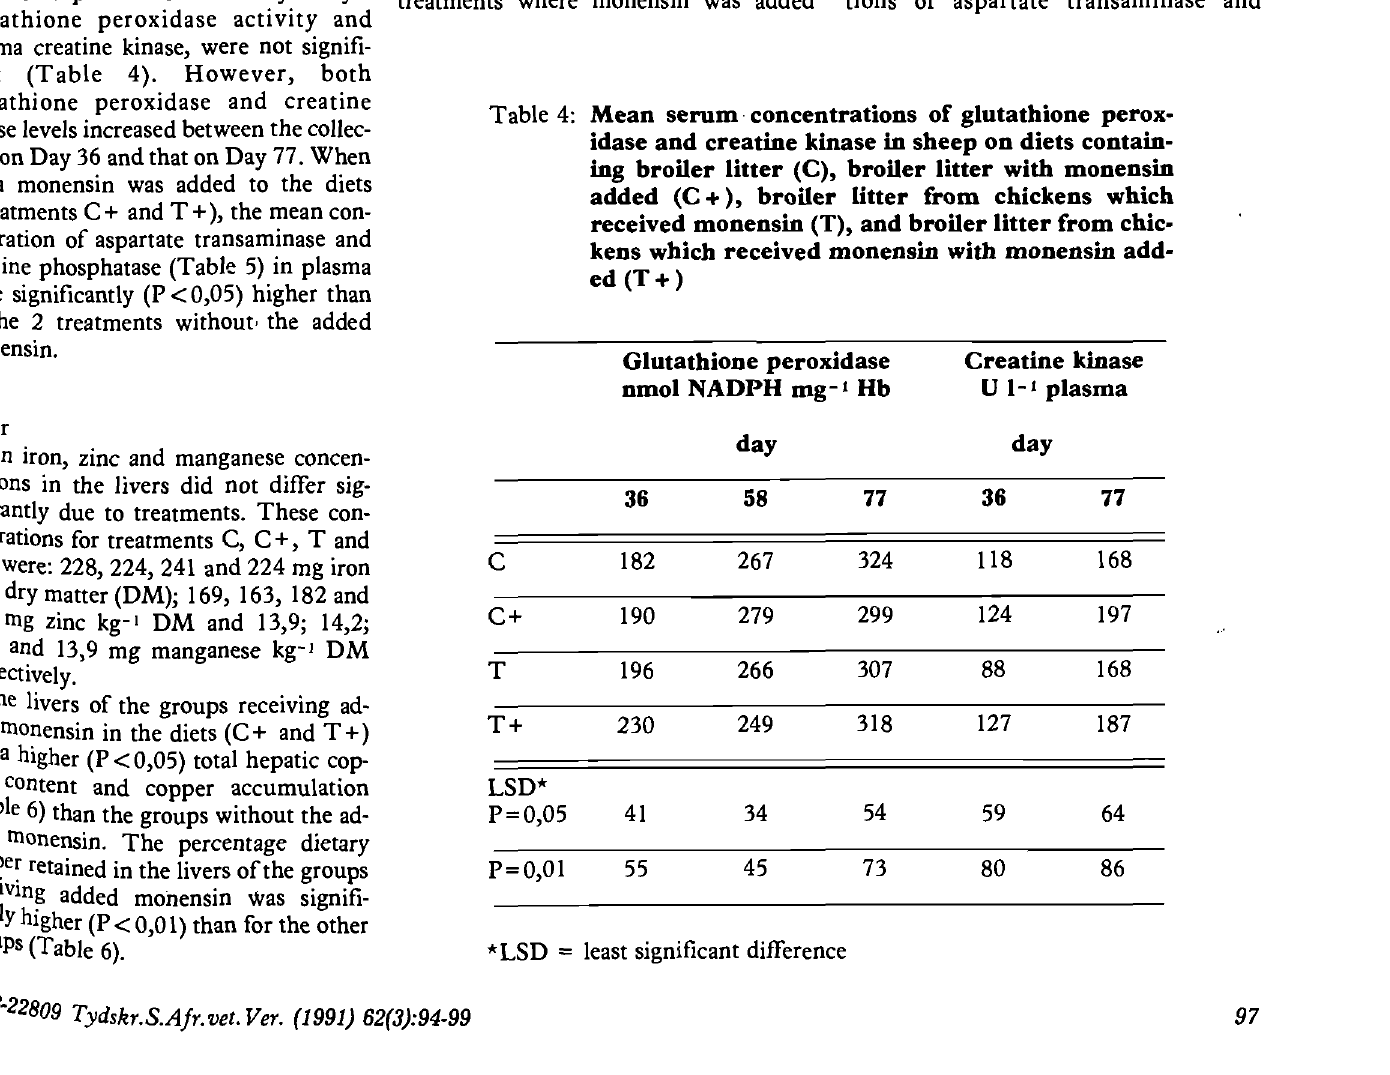
Table 4: Mean serum concentrations of glutathione perox- idase and creatine kinase in sheep on diets contain- ing broiler litter (C), broiler litter with monensin added (C +), broiler litter from chickens